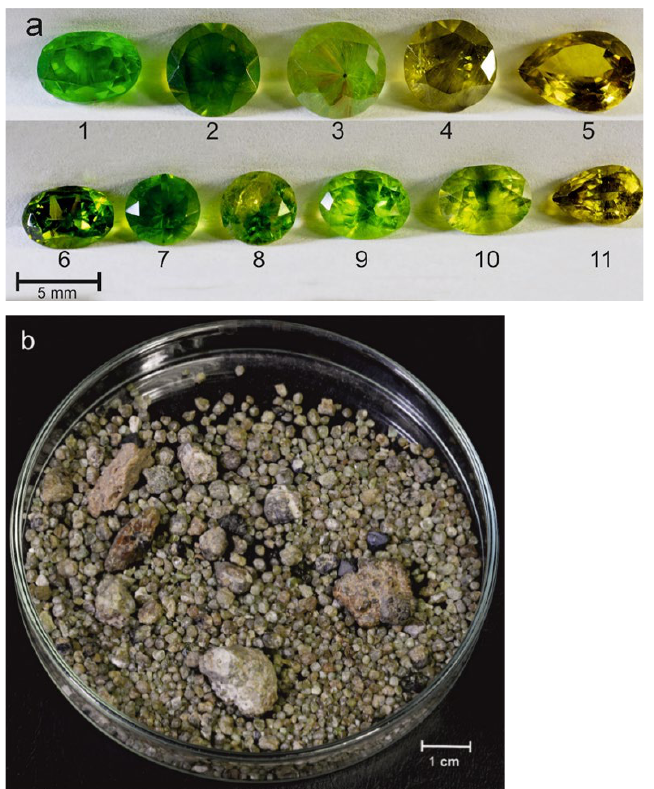
Figure 4. Research material: ( a ) collection of faceted demantoids with “horsetail” inclusions sourced from Poldnevskoye (1–2), Elizavetinskoye (3; alluvial), and Korkodinskoye (4–11); and ( b ) untreated demantoid (rough material) from the Poldnevskoye deposit.